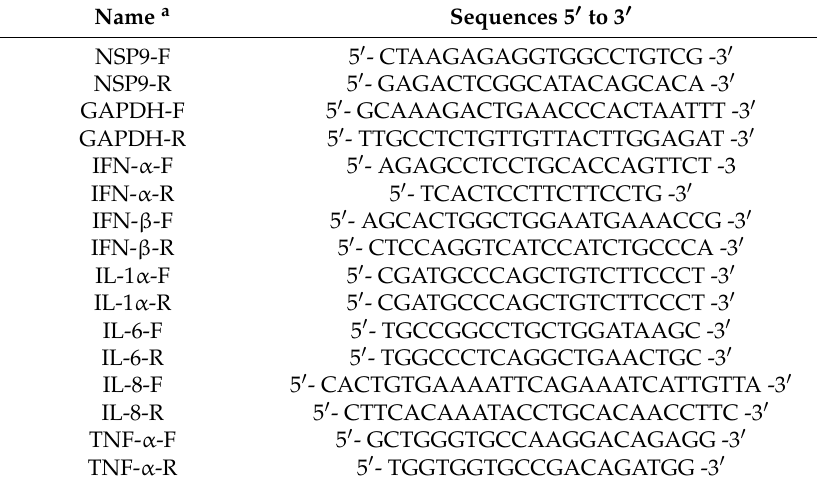
Table 1. Real-time PCR primer